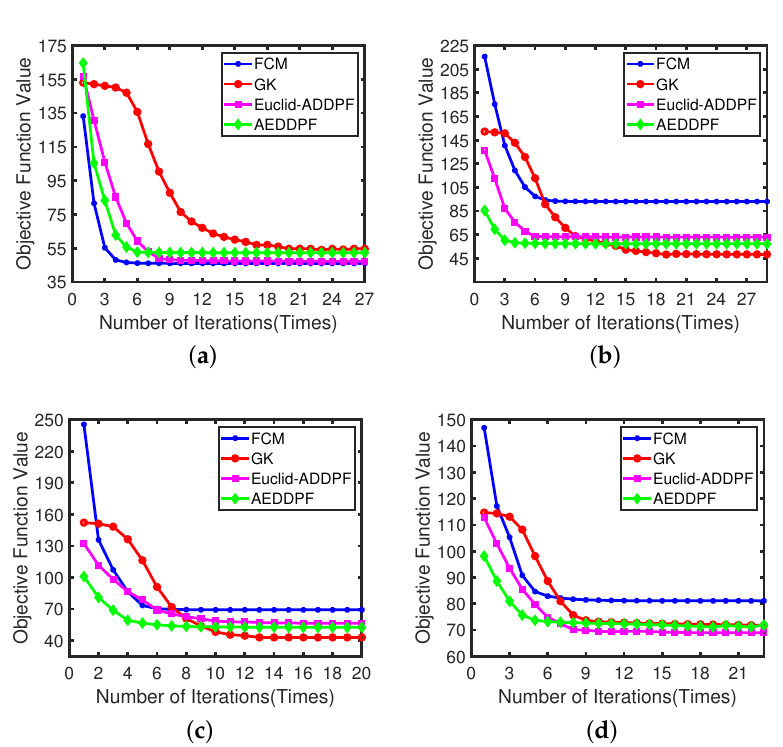
Figure 12. Decibels of fuzzy c -means (FCM), Gustafson-Kessel (GK), Euclidean distance density peak fuzzy (Euclid-ADDPF), and AEDDPF clustering algorithms were applied to the comparative experiment of Scene1 to Scene4 analyze the broken line graph: ( a ) Operational efficiency of Dataset1; ( b ) Operational efficiency of Dataset2; ( c ) Operational efficiency of Dataset3; ( d ) Operational efficiency of